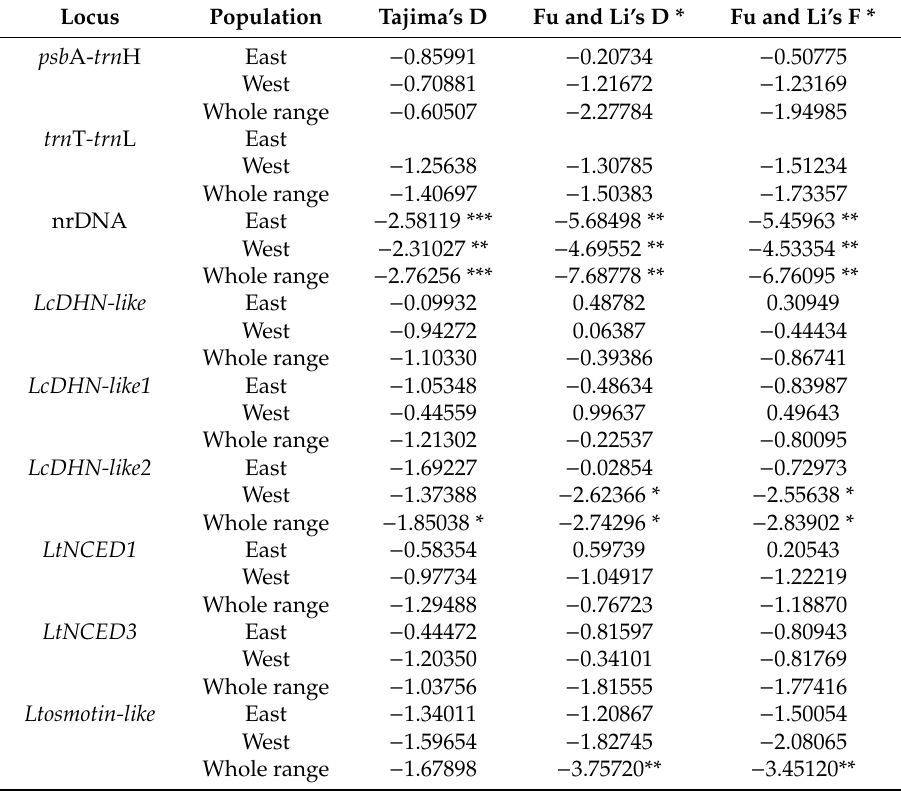
Table 6. Neutrality test values of all loci based on nucleotide